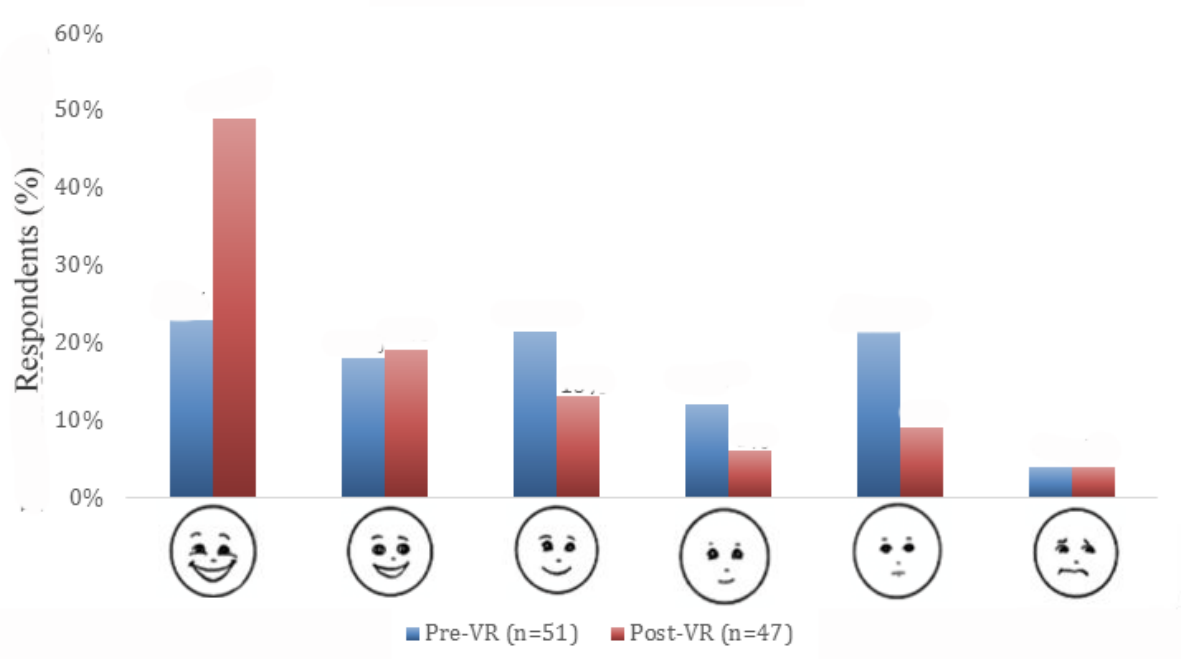
Figure 5. Self-reported affect pre- and post-DocVR gameplay experience. Faces 7-9 (faces that represent the 3 most distressed affects) were not selected by any participants pre- or post-DocVR and are thus not represented in the